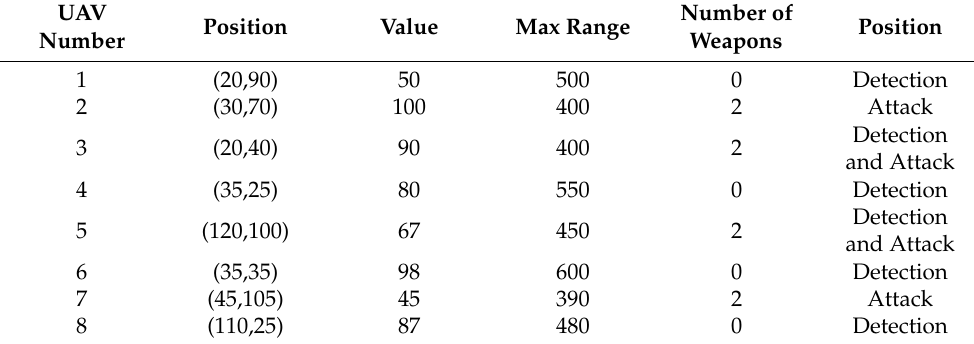
Table 2. UAV parameters.